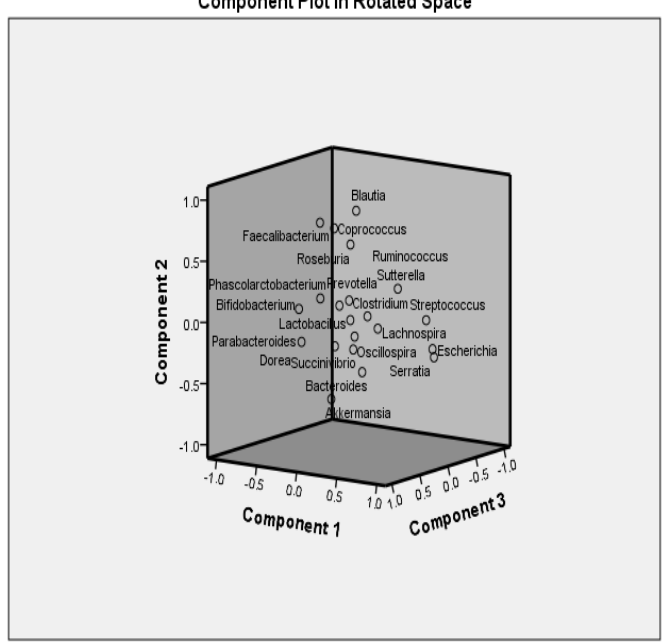
Fig. 2a. Spatial representation of relationships between derived factors and bacteria genus- groups among